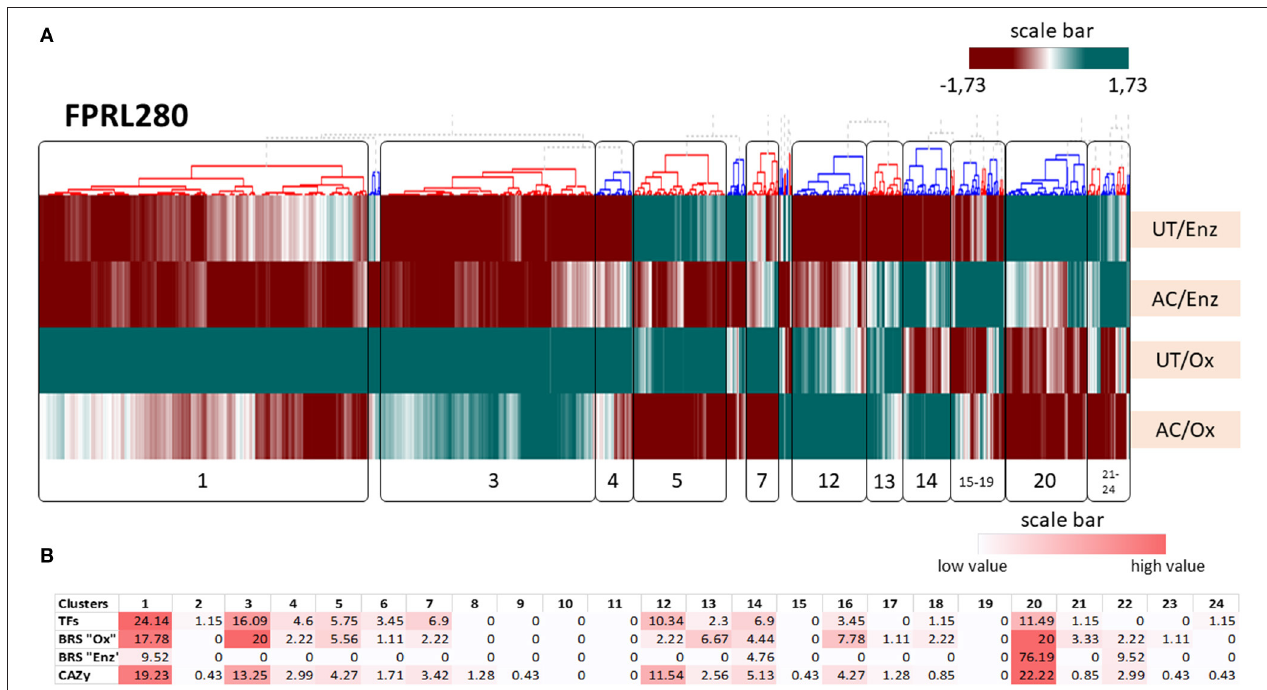
FIGURE 6 | Results for the hierarchical clustering of the transcriptomes of R. placenta FPRL280 in all tested conditions. (A) UT/Enz: untreated samples during enzymatic decay; AC/Enz: acetylated samples during enzymatic decay; UT/Ox: untreated samples during oxidativ e decay; AC/Ox: acetylated samples during oxidative decay. (B) Heat map of brown rot specific genes (BRS), CAZy genes and transcription factors (TFs). The numbers represent the percentage [%] of the abundance of genes of the respective group. To annotate TFs, different references (Martinez et al., 2009; Zhang et al., 2019, UniProt, MycoCosm) were used and the respective orthologs from R. placenta and G. trabeum identified.